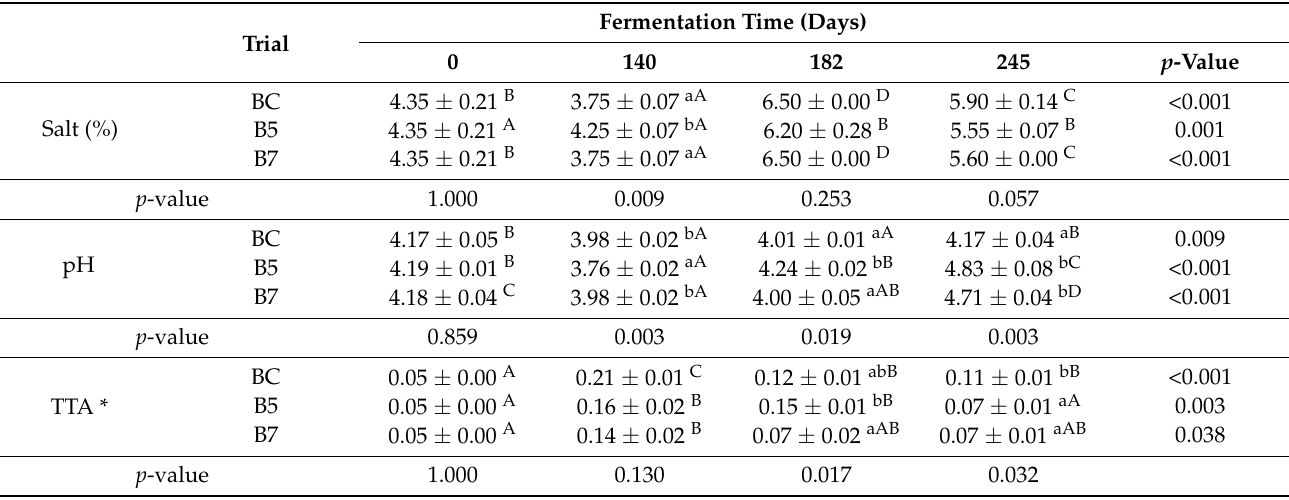
Table 2. Evolution in physicochemical features (salt content, pH, and total titratable acidity) of brine at selected times of fermentation under plan B.